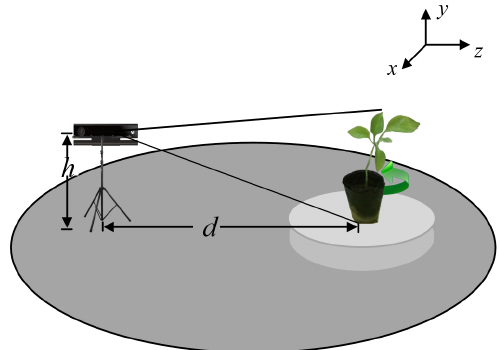
Figure 2. Measurement system of plant phenotypic